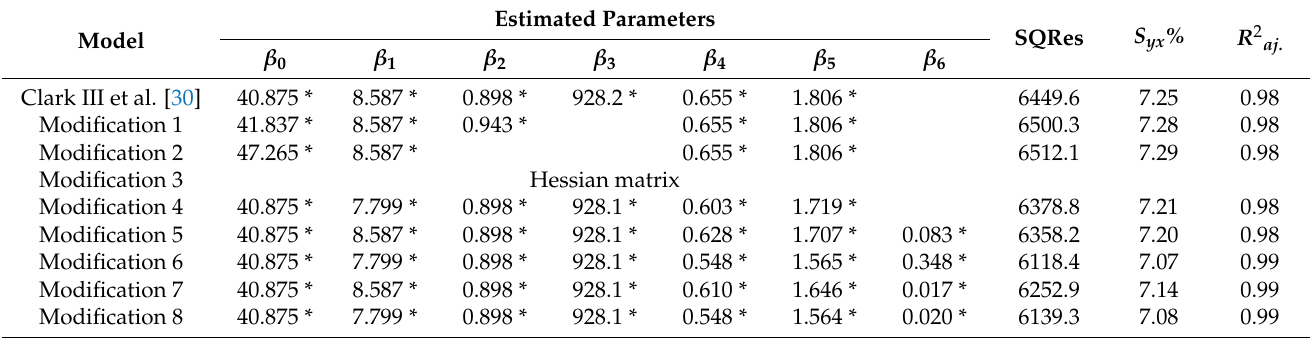
Table 9. Estimated parameters and adjustment and precision statistics obtained in the adjustment of Clark III et al.’s model and after the proposed modifications of the same model for Tectona grandis L.f., central-west region,